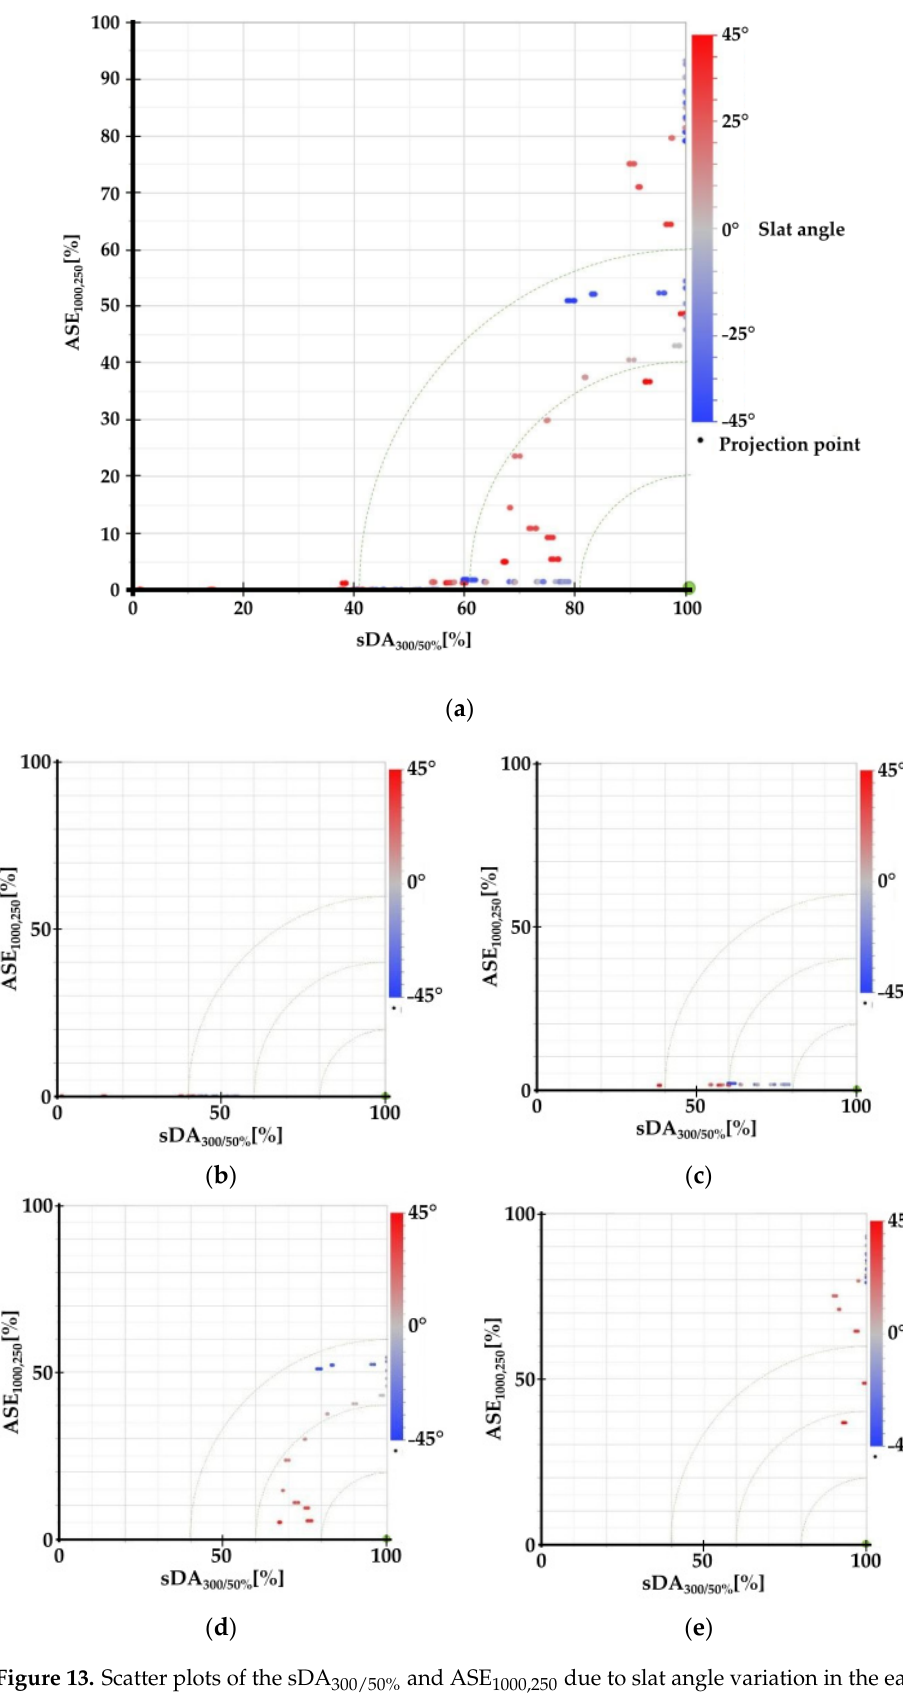
Figure 13. Scatter plots of the sDA 300/50% and ASE 1000,250 due to slat angle variation in the east zone, for ( a ) all scenarios, ( b ) scenario k 1 , ( c ) k 2, ( d ) k 3 , ( e ) k 4 .